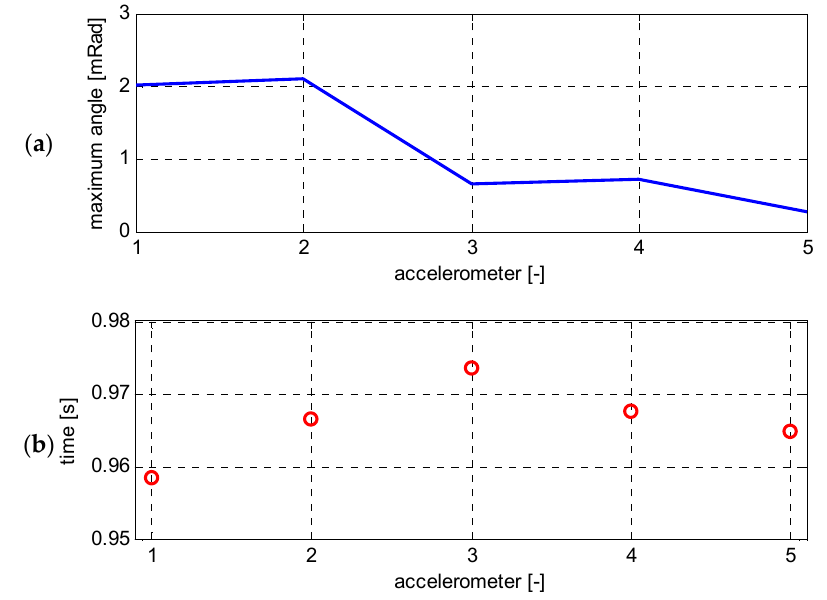
Figure 26. The results of the single impulse test: ( a ) Accelerometer number–maximum angle, ( b ) Accelerometer number–time. Material: saclSi 1; Isotropic pressure 20 kPa; Amplitude 8.6 V; Impulse duration 50